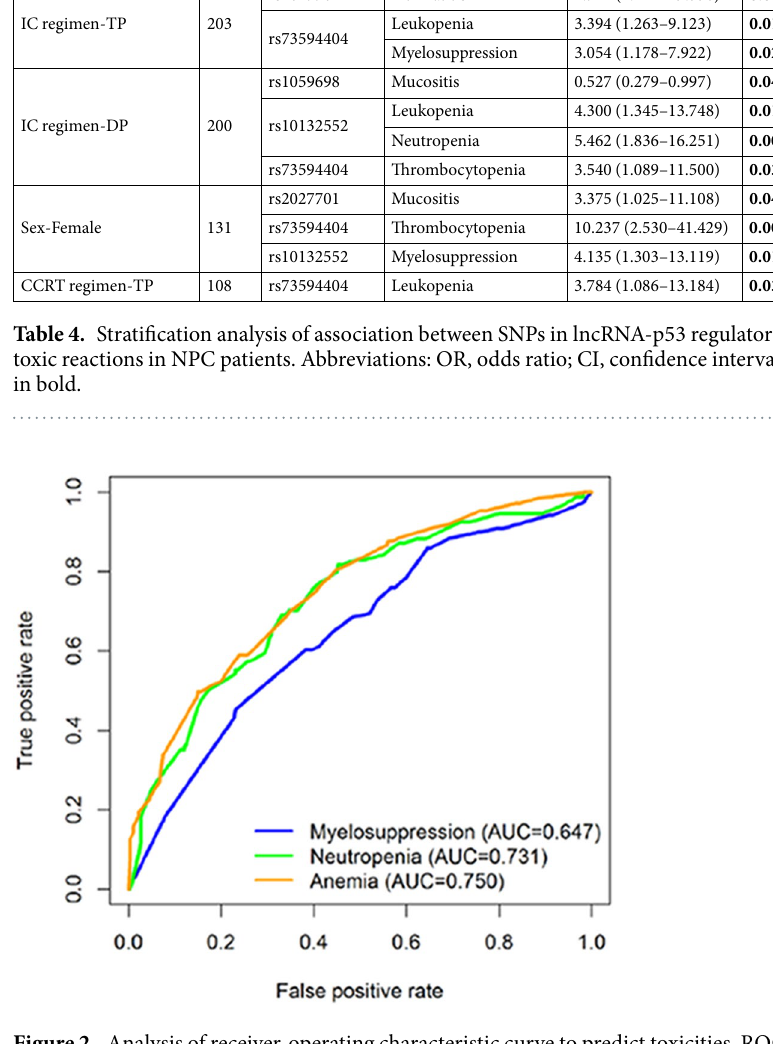
Figure 2. Analysis of receiver-operating characteristic curve to predict toxicities. ROC analysis showed the AUC of myelosuppression, neutropaenia and anaemia was 0.647, 0.731 and 0.750,